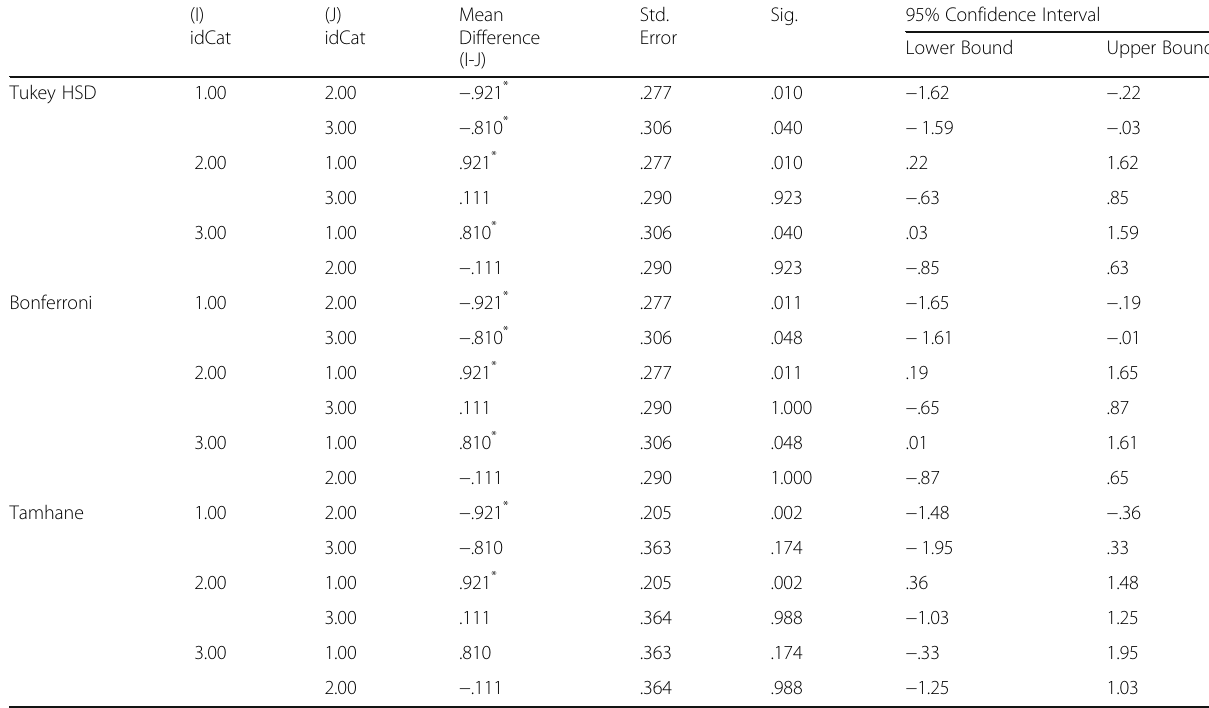
Table 4 Multiple Comparisons FV exon